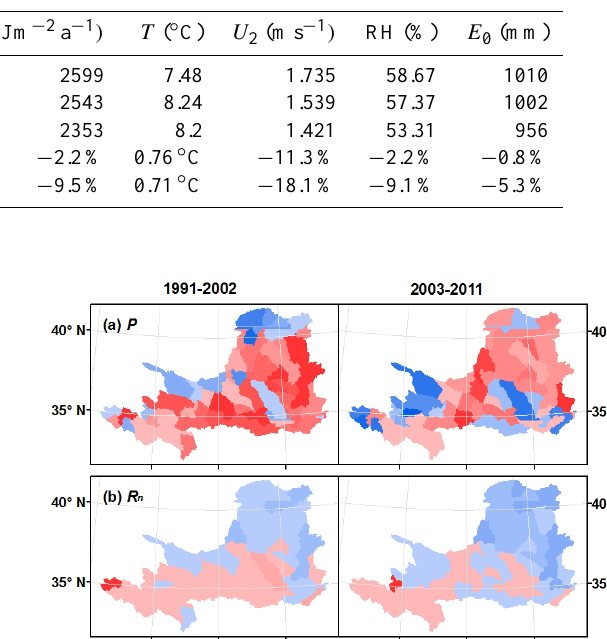
Table 1. Mean annual climatic variables and potential evaporation of the study area in the baseline (1960–1990), low-flow (1991–2002), and recent (2003–2011) periods.